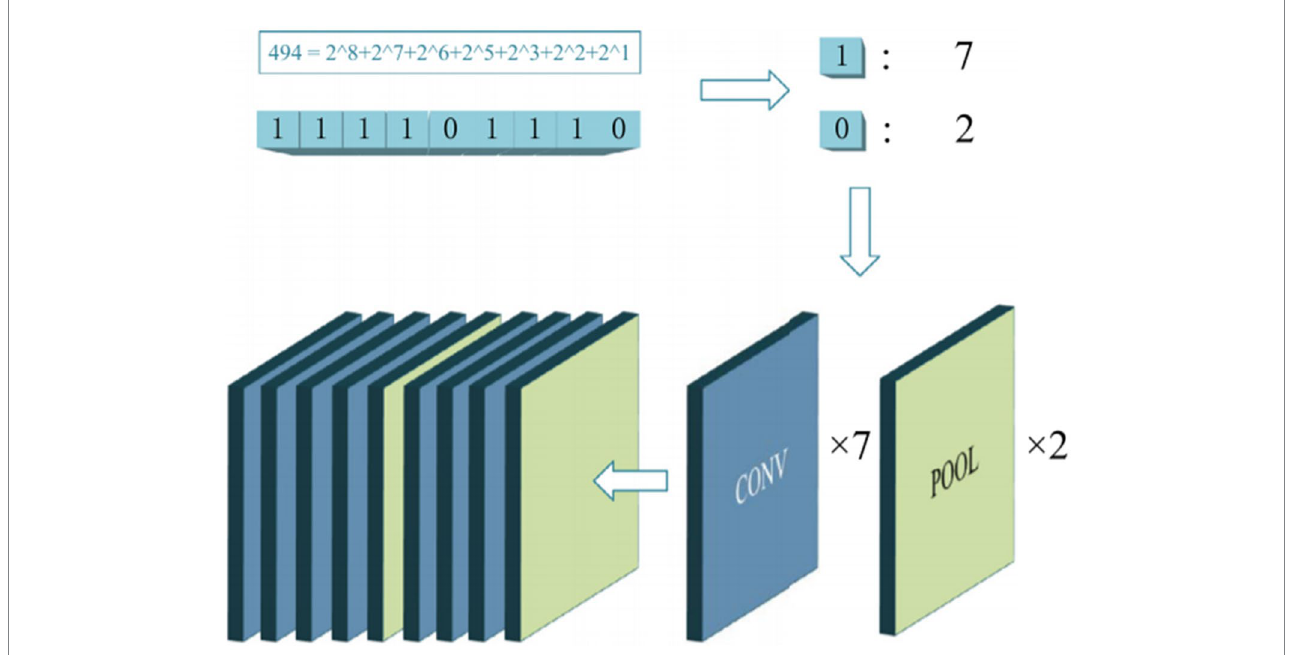
FIGURE 11 The schematic diagram of the GPSO algorithm (Gao et al., 2020). Reproduced with permission from Elsevier. Licence Number: